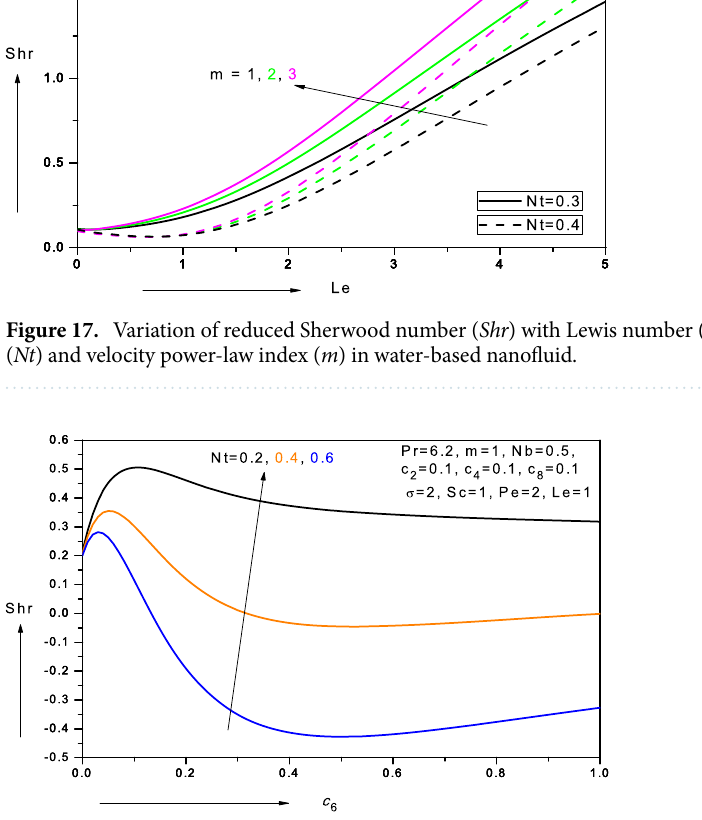
Figure 18. Variation of reduced Sherwood number ( Shr ) with nano-particle species diffusivity parameter ( c 6 ) and thermophoresis parameter ( Nt ) in water-based nanofluid.